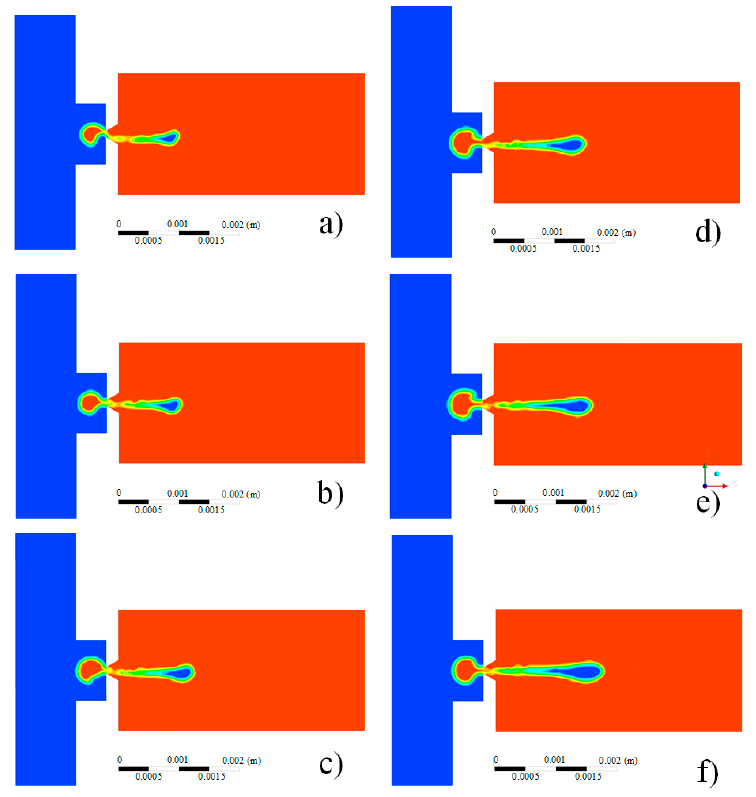
Figure 8. The injection status varies with different voltage amplitudes: ( a ) 50 V; ( b ) 60 V; ( c ) 75 V; ( d ) 90 V; ( e ) 100 V; ( f ) 125 V.